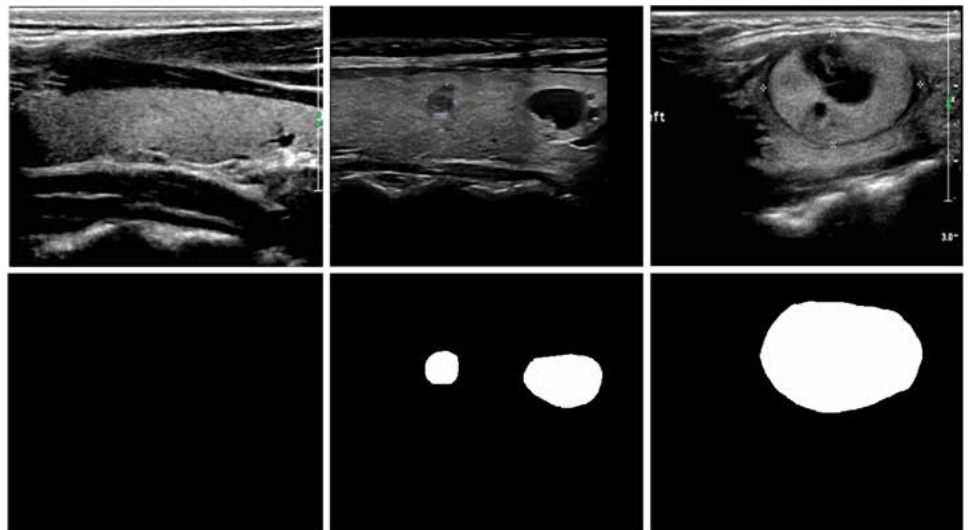
Figure 2 Typical sub-images of thyroid nodule(s) and normal thyroid (top), and the corresponding binary masks (bottom) used for training the convolutional neural network.